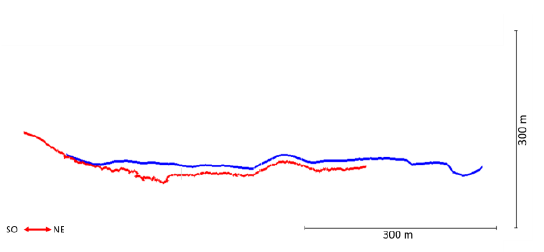
Figure 16. Comparison between 2014 DPCs (in blue) and 2016 DPC (in red) along Section 4.